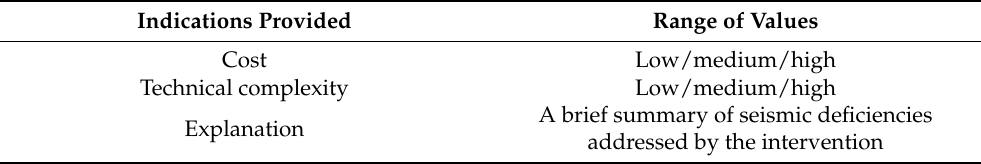
Table 7. Qualitative indicators for seismic